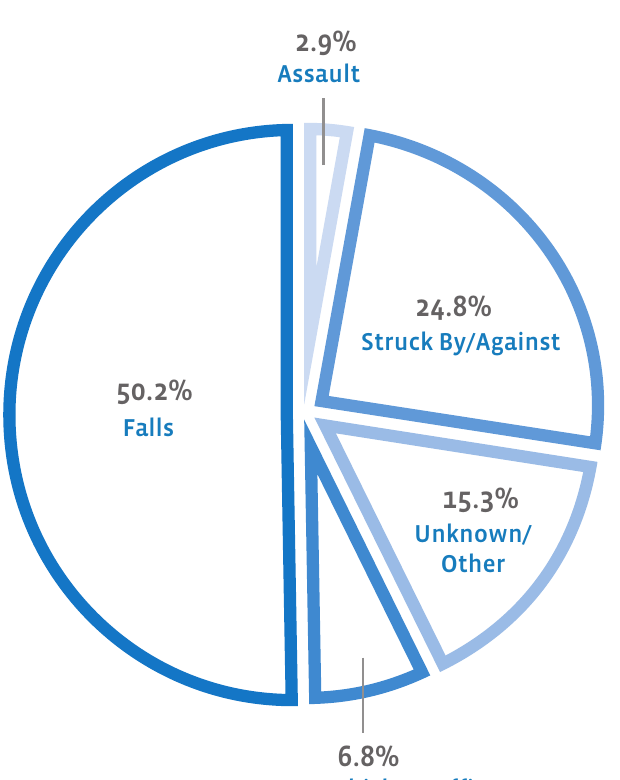
FIGURE 7: Estimated Average Percentage of Annual Traumatic Brain Injury-Combined Emergency Department Visits, Hospitalizations, and Deaths Among Adults 65 Years and Older, by External Cause, United States,